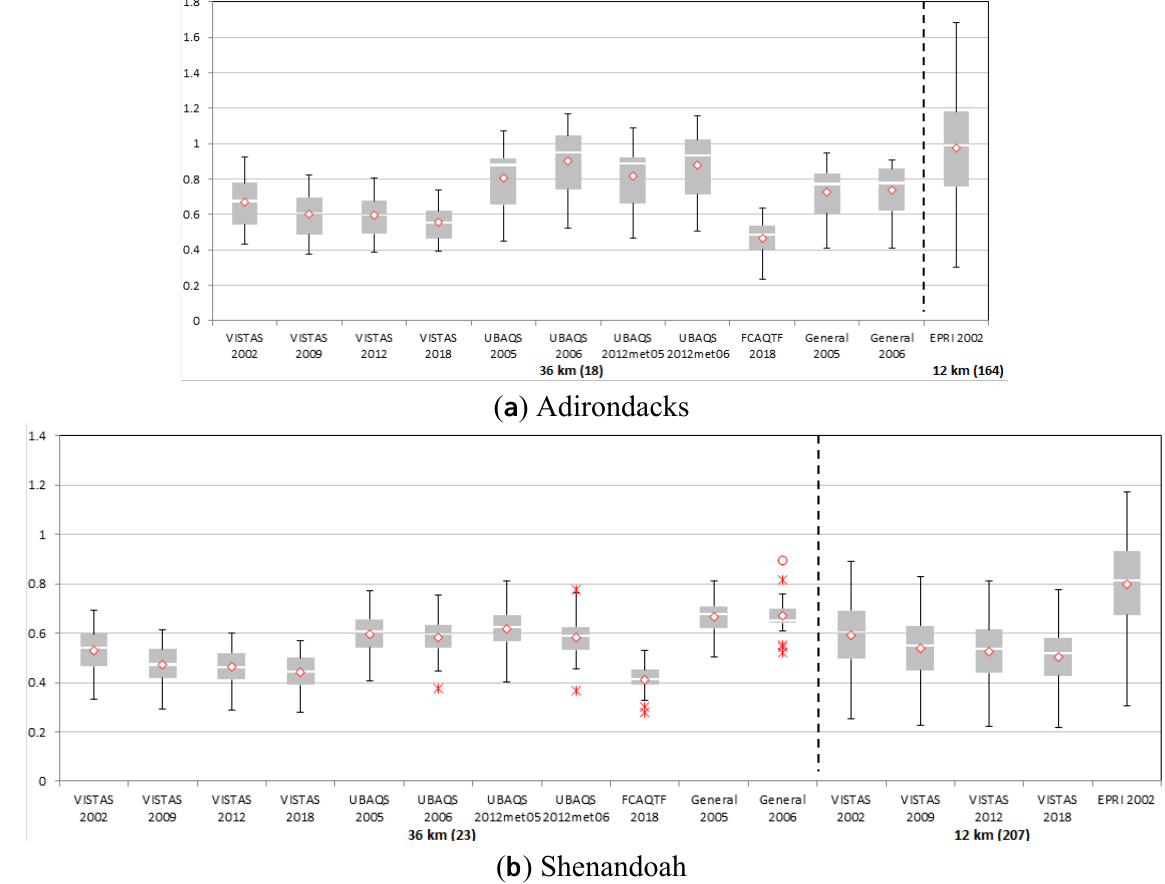
(kg-N/ha/year) at ( a ) Adirondacks X